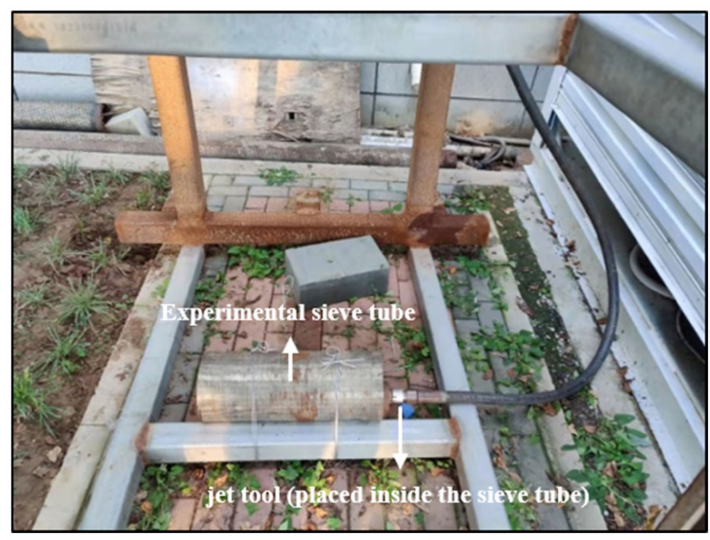
Figure 5. Experiment device